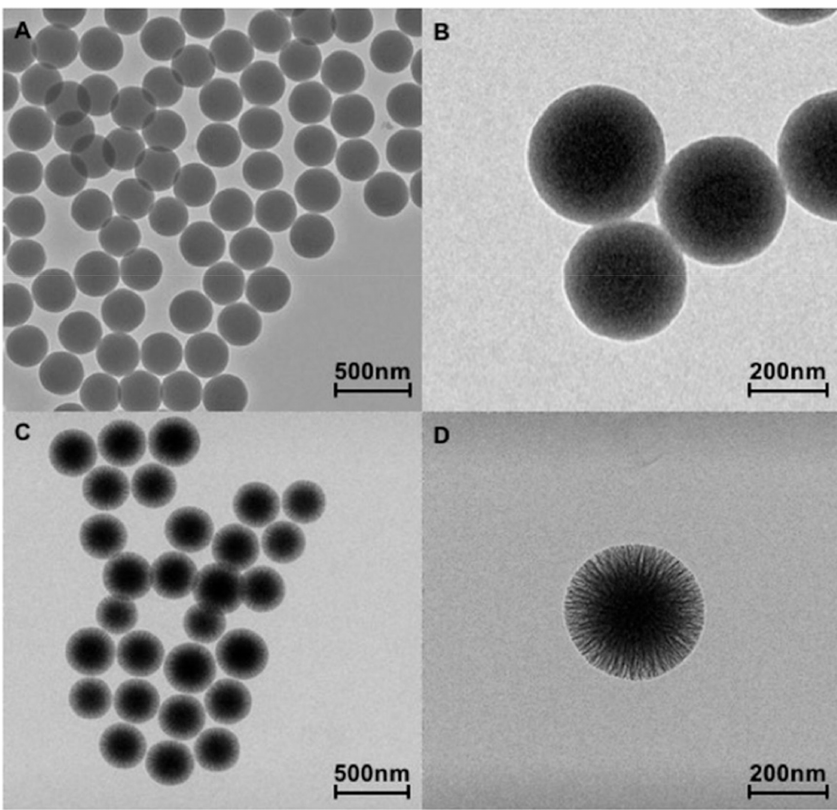
Figure 1. TEM images of SiO 2 _s NPs (smooth) ( A , B ) and SiO 2 _w ( C , D ) nanoparticles (wrinkled) at di ff erent